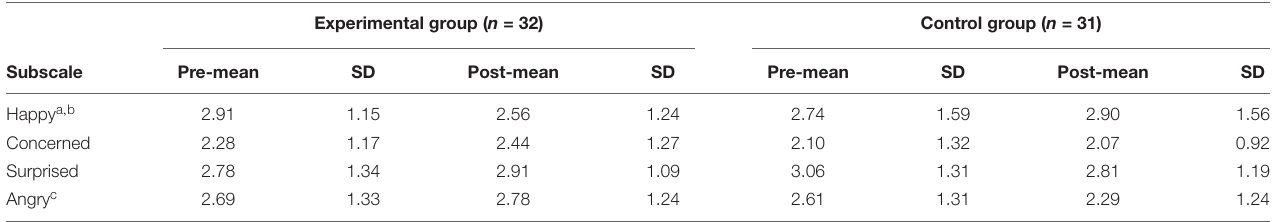
TABLE 2 | Pre- and post-test differences in emotions induced by memory